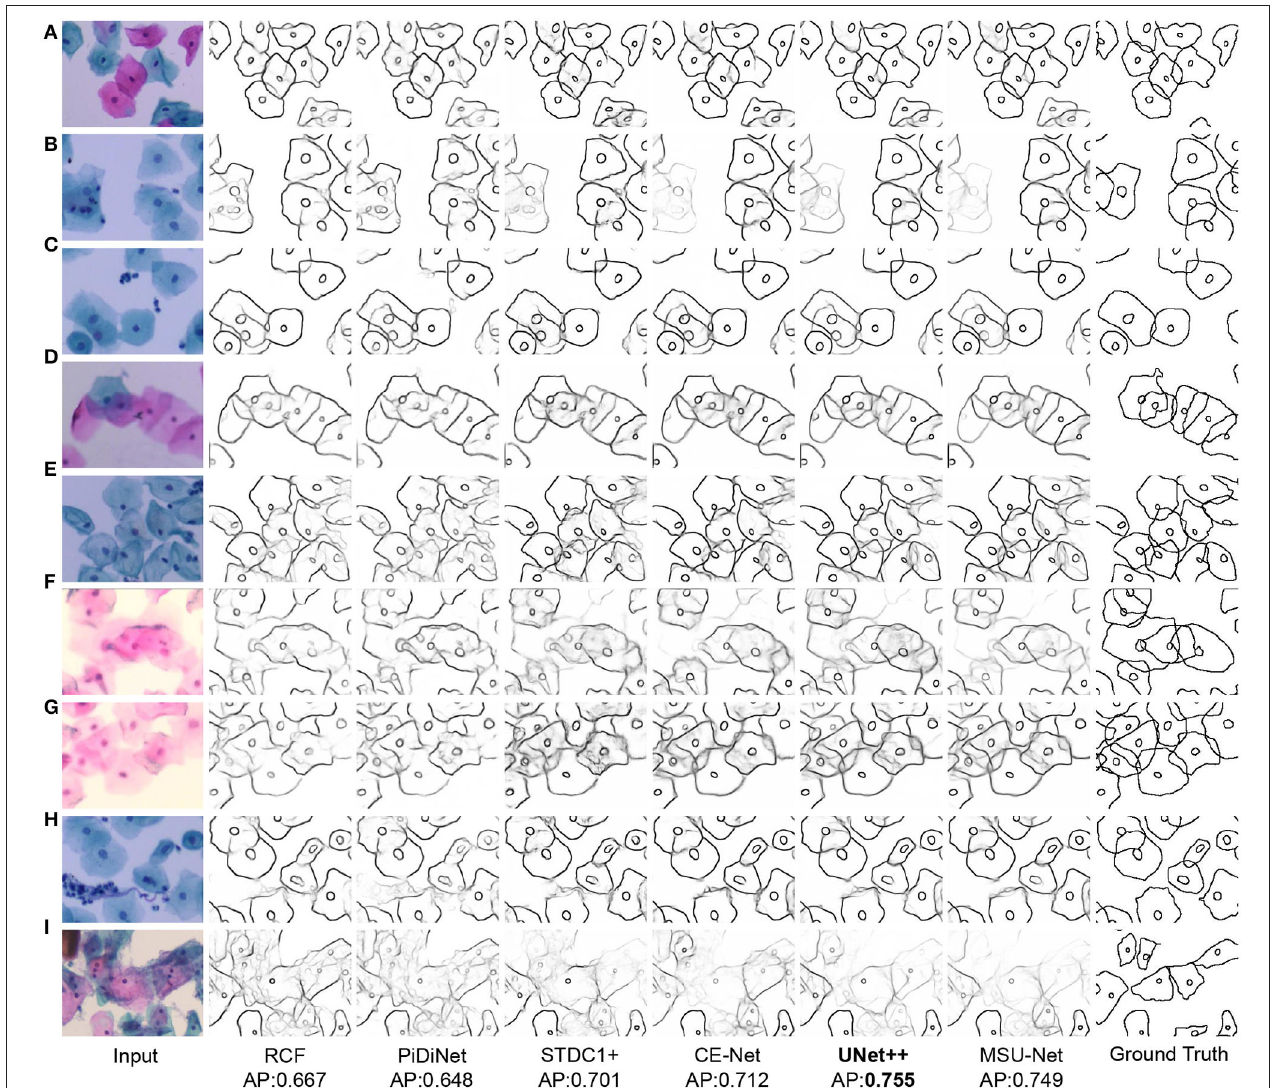
FIGURE 6 | Visual comparison results on CCEDD dataset. (A) Slightly overlapping cells. (B,C) Highly overlapping cells. (D,E) Overlapping cell masses. (F,G) Blurred overlapping cells. (H,I) Overlapping cells in complex environments.